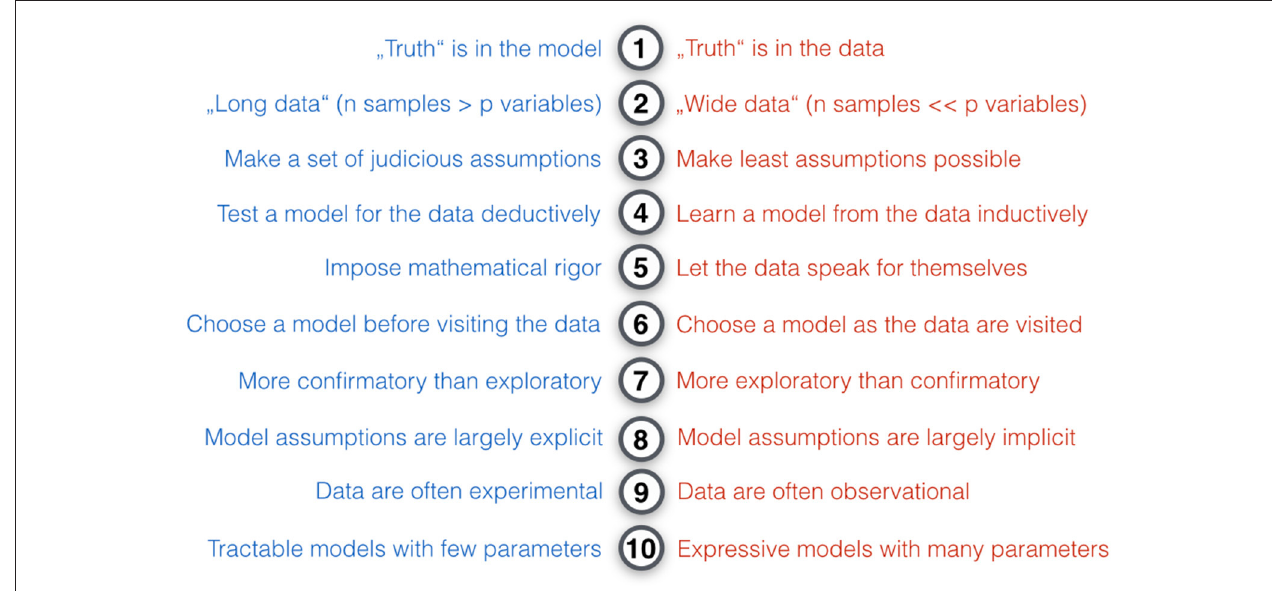
FIGURE 3 | Key differences in the modeling philosophy of classical statistics and statistical learning. Ten modeling intuitions that tend to be relatively more characteristic for classical statistical methods (blue) or pattern-learning methods (red). In comparison to ClSt, StLe “is essentially a form of applied statistics with increased emphasis on the use of computers to statistically estimate complicated functions and a decreased emphasis on proving confidence intervals around these functions” ( Goodfellow et al., 2016). Broadly, ClSt tends to be more analytical by imposing mathematical rigor on the phenomenon, whereas StLe tends to be more heuristic by finding useful approximations. In practice, ClSt is probably more often applied to experimental data, where a set of target variables are systematically controlled by the investigator and the brain system under studied has been subject to experimental perturbation. Instead, StLe is probably more often applied to observational data without such structured influence and where the studied system has been left unperturbed. ClSt fully specifies the statistical model at the beginning of the investigation, whereas in StLe there is a bigger emphasis on models that can flexibly adapt to the data (e.g., learning algorithms creating decision